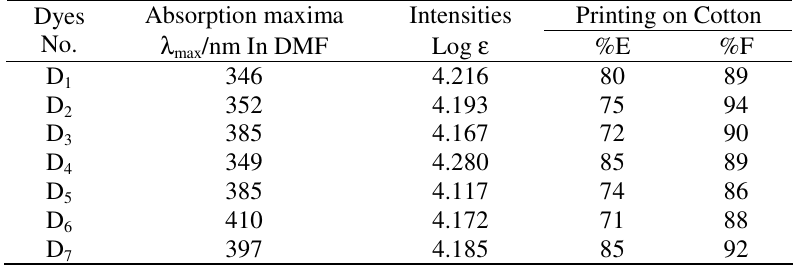
) , intensities (log ε ), exhaustion (E) and fixation (F) of max